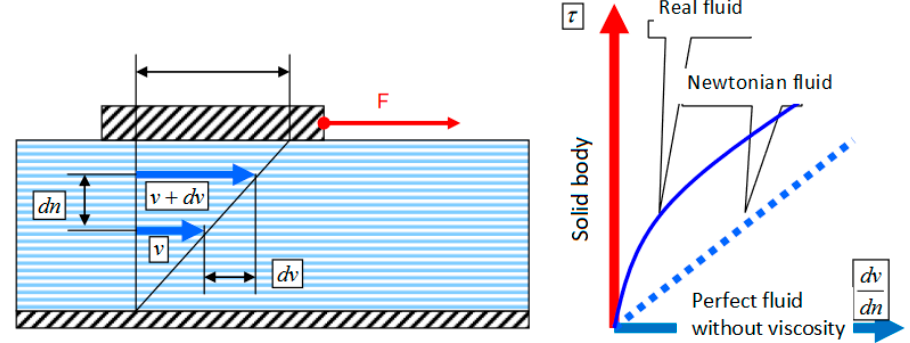
Figure 1. Newton’s experiment for viscosity.